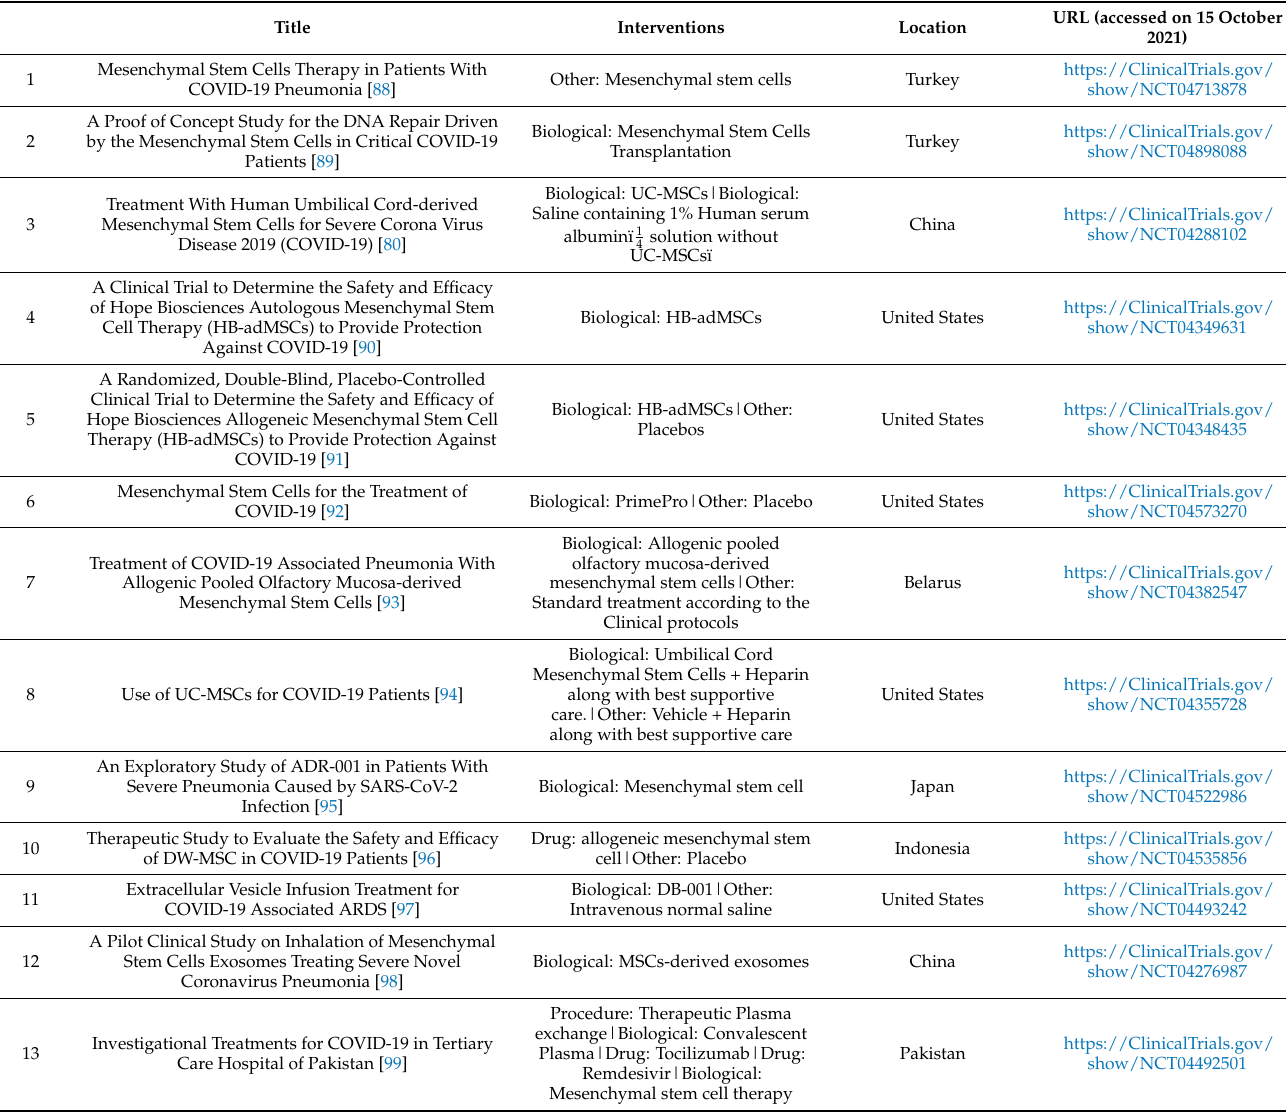
Table 1. List of completed clinical trials studying MSC therapy’s safety and efficacy to treat COVID-19